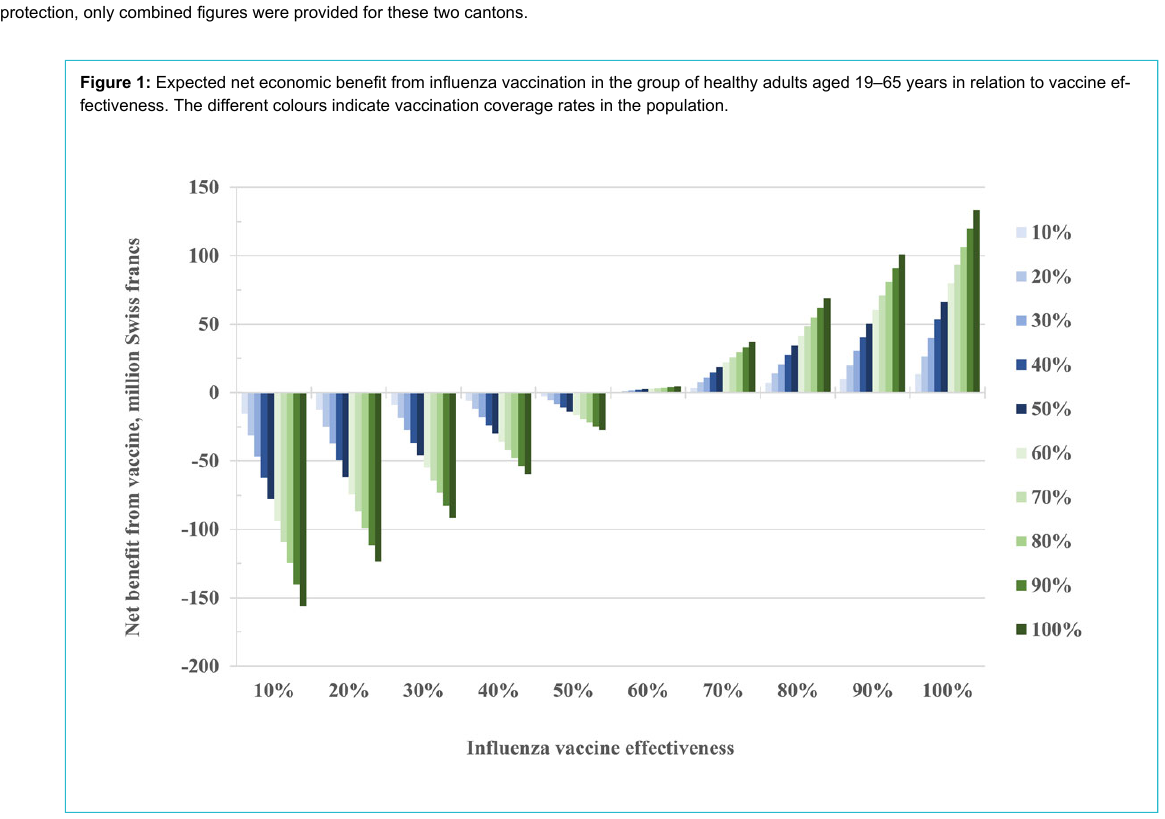
Benefits from Net bene- tion vaccination fits (CHF) (CHF) (CHF)